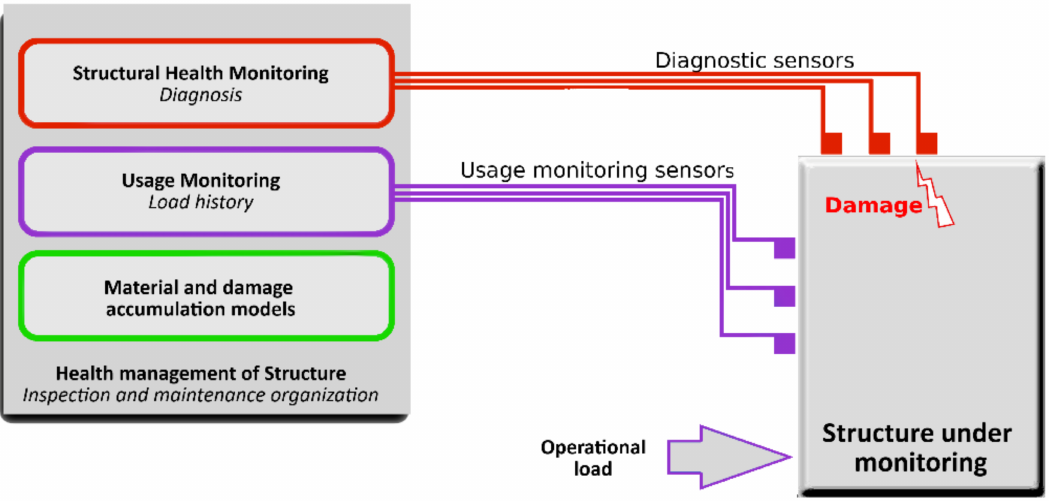
Figure 1. Scheme of an SHM system